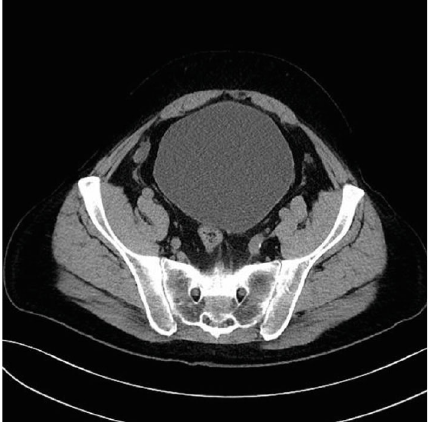
Figure 3: Noncontrast CT abdomen in transverse plane again demonstrates enlarged bladder with no appreciable surrounding enlarged lymph